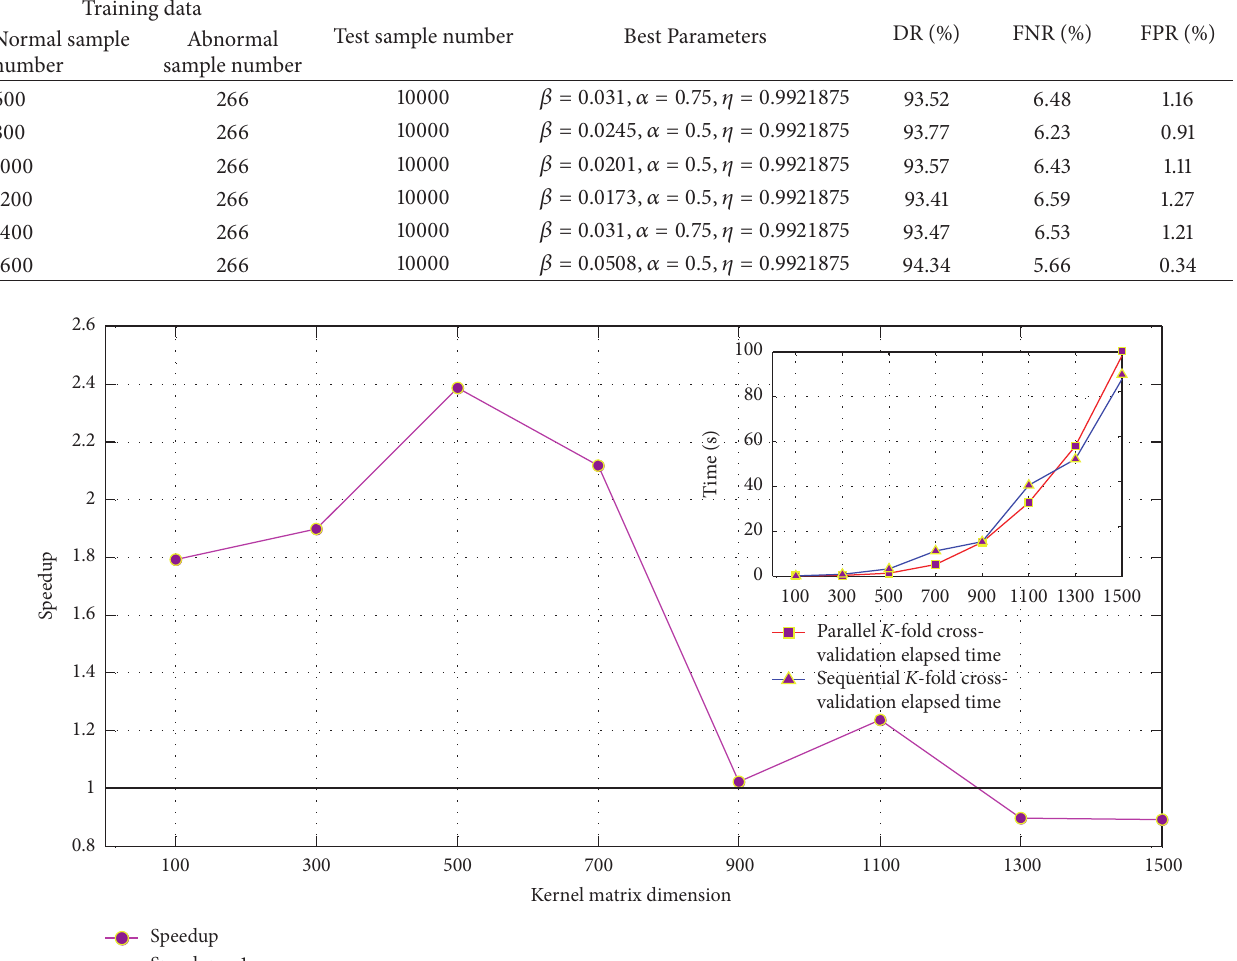
Table 2: Detection performance by the improved KPCA method.